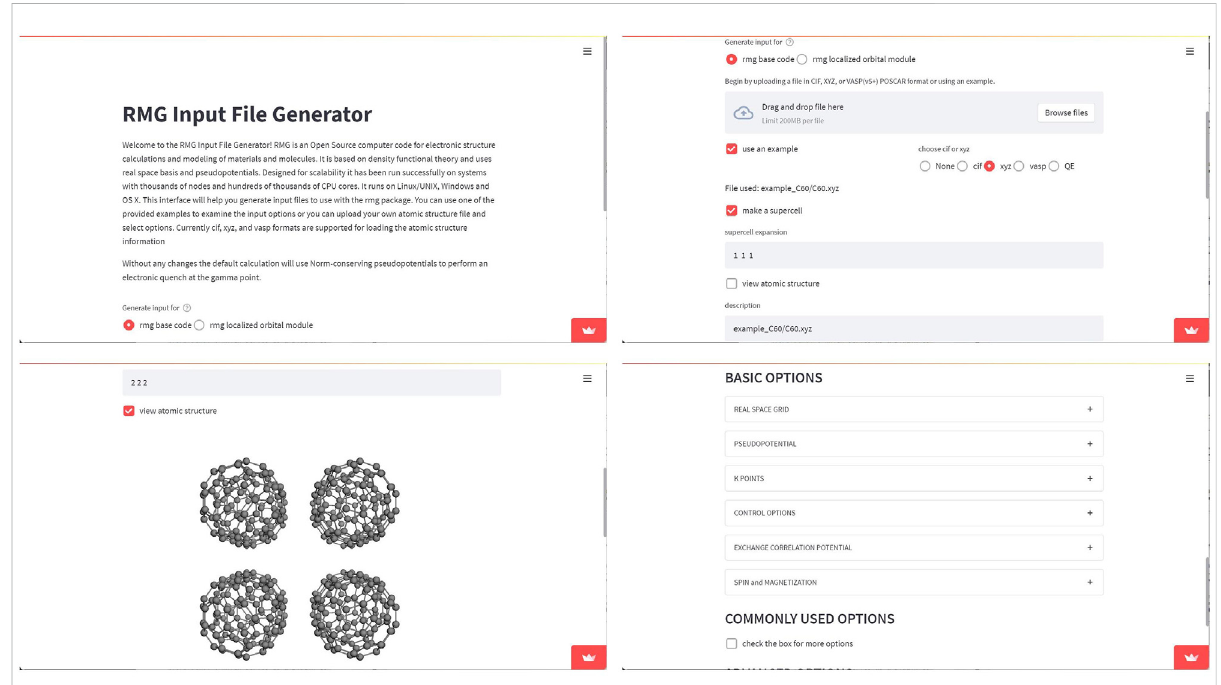
FIGURE 8 Screen-captures of RMG web-app. The showmol () function was called for the purpose of rendering crystalline structures. The end user can select the options accepted by the RMG code and visualize the crystal using repetition cells.